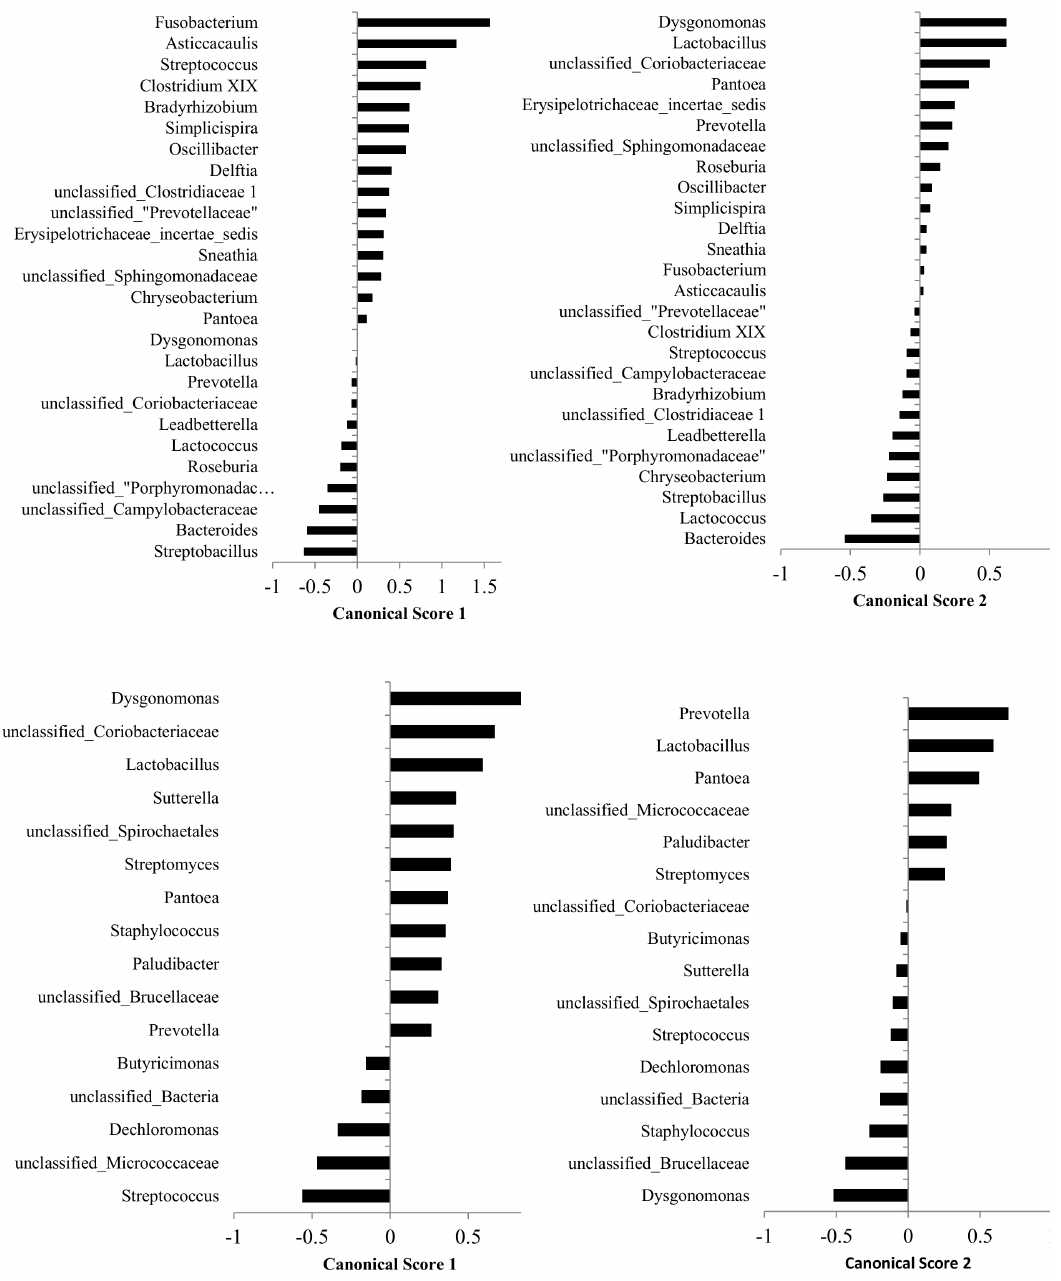
Figure 3. Canonical scores 1 and 2 for genera that were found to be significant for the discriminant analysis (displayed in Figure 2I) of milk microbiome by milk samples groups performed using all 5 groups (top) and canonical scores 1 and 2 for genera that were found to be significant for the discriminant analysis (displayed in Figure 2II) of milk microbiome by milk samples group 1 to 4, excluding group 5